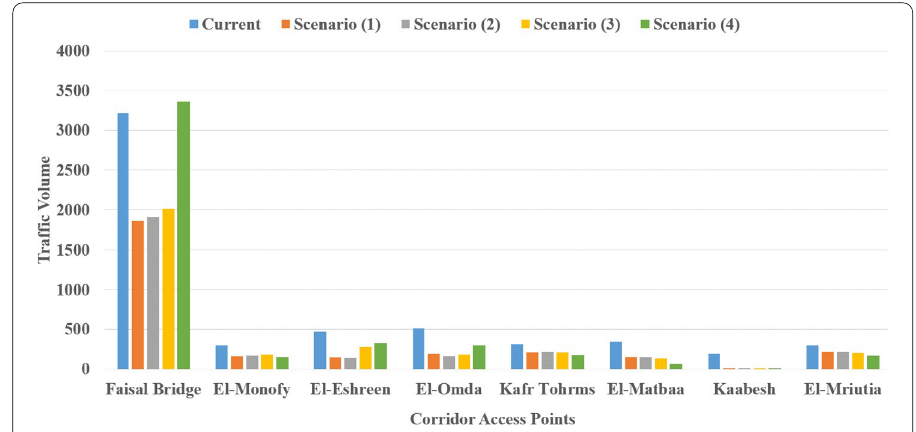
Fig. 8 Accommodated traffic volumes versus original traffic